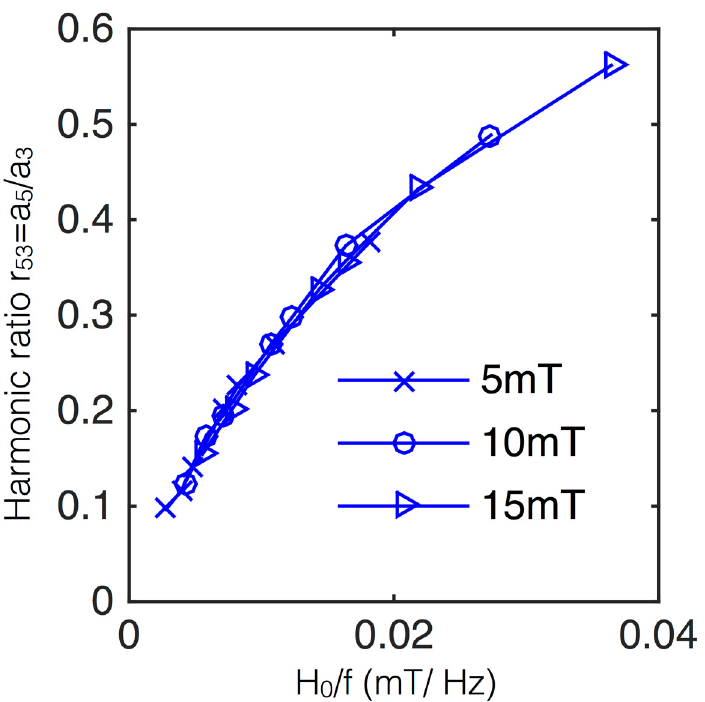
Fig 4. The approximate scaling relationship between field amplitude and frequency is demonstrated experimentally. The ratio of the fifth to third harmonic r 53 = a 5 / a 3 from the same nanoparticles at different oscillating field amplitudes ranging from 5 – 15 mT is plotted against the ratio of the field amplitude to the frequency. The spectra are equivalent, illustrating the scaling